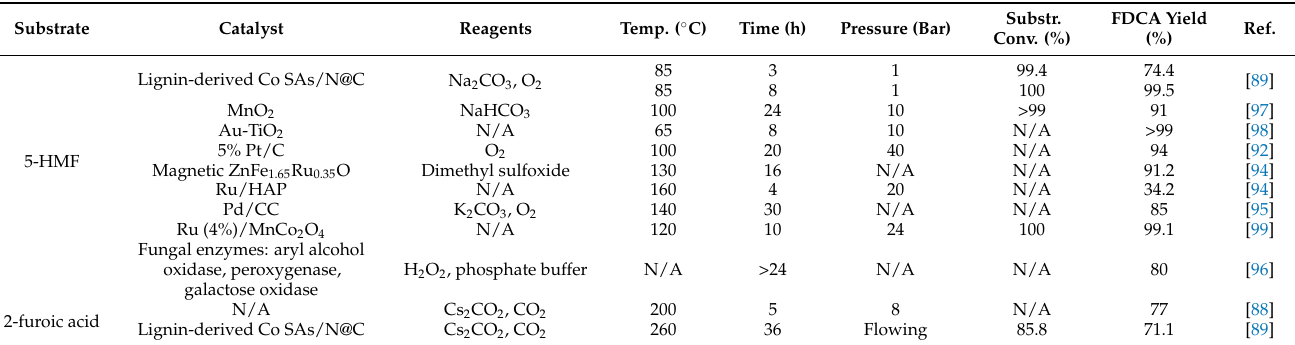
Table 5. Review of oxidation processes from sugar-derived 5-hydroxymethylfurfural (5-HMF)